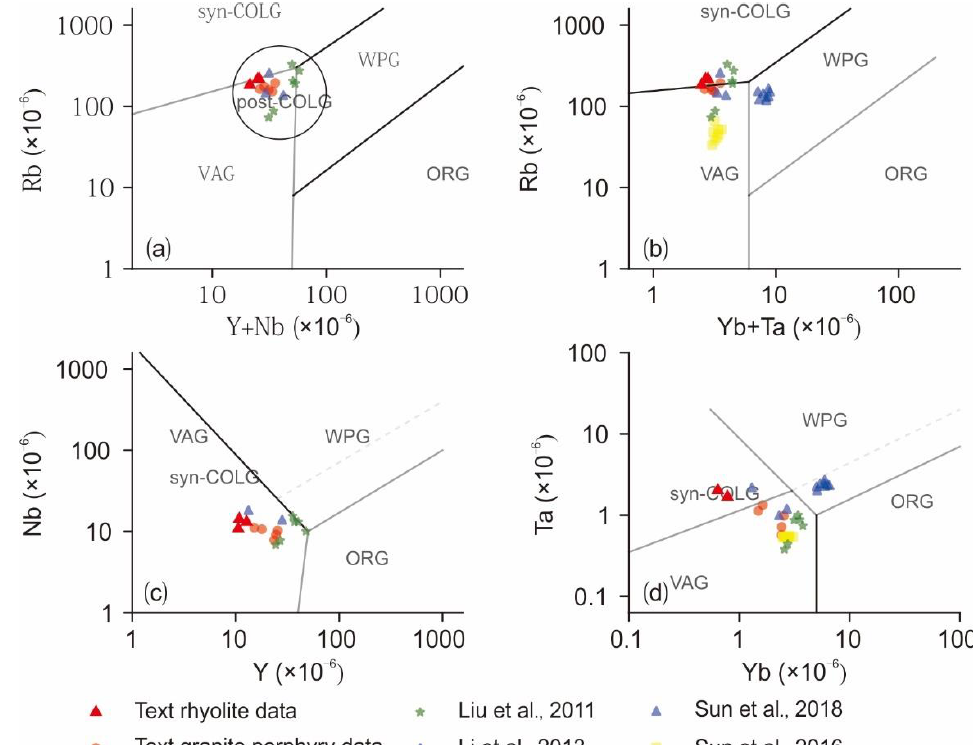
Figure 10. Tectonic discrimination diagrams for magmatic rocks (base image according to [82]). ( a ) Rb vs. (Y + Nb) diagram; ( b ) Rb vs. (Yb + Ta) diagram; ( c ) Nb vs. Y diagram; ( d ) Ta vs. Yb diagram. Syn-COLG, syn-collision granite; VAG, volcanic arc granite; WPG, within plate granite; ORG, ocean ridge granite; post-COLG, post-collision granite. The samples from Li et al. [17] and Sun et al. [44] are granite porphyries not far from the study area along the Ailaoshan orogenic belt. The samples from Liu et al. [54] and Sun et al. [43] are volcanic rocks not far from the study area along the Ailaoshan orogenic belt.